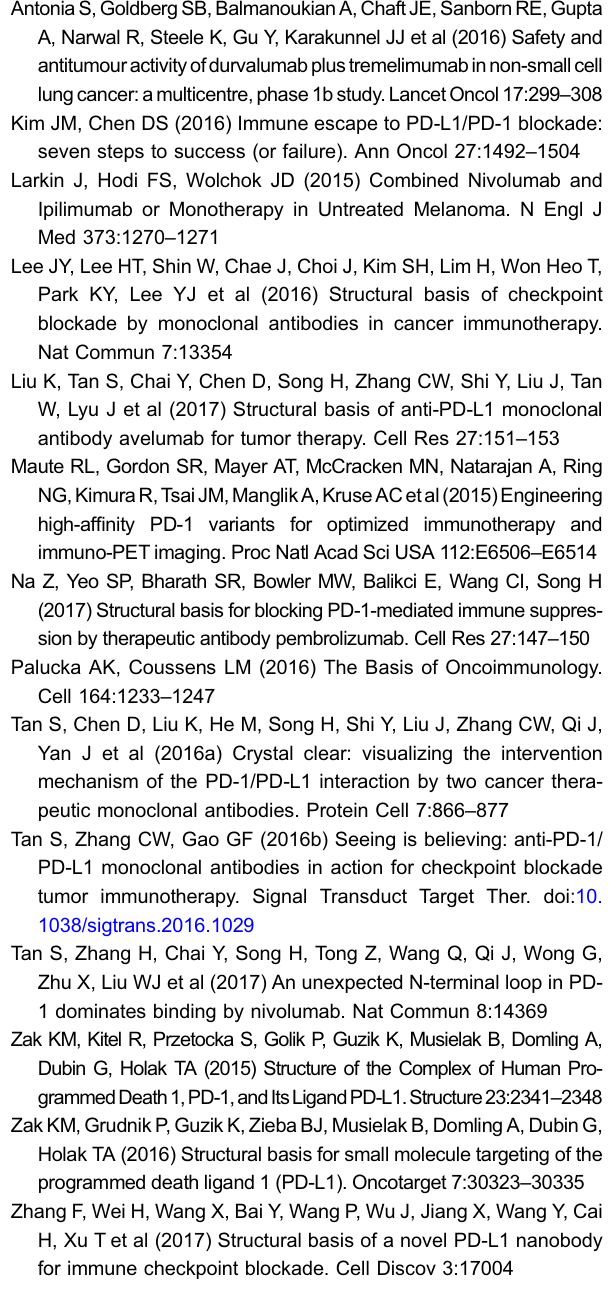
Figure 2. Comparison of the binding mode and kinetics of anti-PD-L1 MAbs . (A) Superimposition of PD-1/PD-L1 complex and PD-L1 complexed with avelumab (PDB: 5GRJ), BMS- 936559 (PDB: 5GGT), and durvalumab. PD-1 is shown in marine, PD-L1 as a surface diagram in light blue, durvalumab in limon, avelumab in magenta and BMS-936559 in cyan, respectively. (B) Binding surface of PD-1 and binding epitopes of avelumab, BMS-936559, and durvalumab on PD-L1. (C) SPR analysis of the binding kinetics of anti-PD-L1 MAbs and PD-L1 using a BIAcoreT100 system. The data presented here are representative of three independent experiments with similar results. (D) Superimposition of the anti-PD-L1 nanobody (KN035)/PD-L1 complex and complex structures of homod- imeric PD-L1 and small-molecule inhibitors, BMS-202 and BMS-8, with durvalumab-scFv/PD-L1. KN035 is shown in hot pink while VL and VH of durvalumab-scFv are presented in light pink and cyan, respectively. The second PD-L1 (PD-L1-a) is presented in orange while small-molecule inhibitors BMS-202 and BMS-8 are shown as sticks in red and blue,